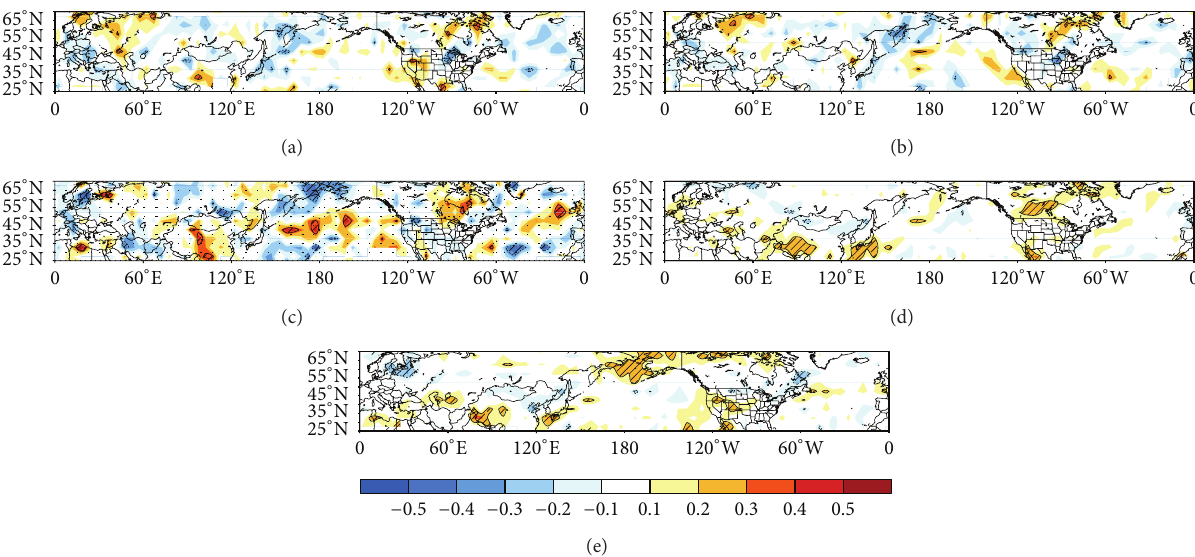
Figure 7: Partial correlation coefficient for storm frequency versus IOD for NH in OND (excluding El Ni˜no). Correlation (shaded), 95% significance (hatched) for (a) NCEP1, (b) ERA40, (c) CFSR, (d) CMIP1, and (e) CMIP2.